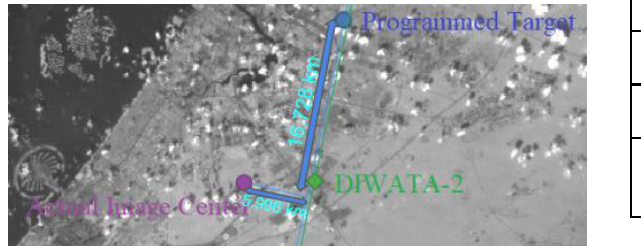
Table 6. Timing/Pointing Errors for